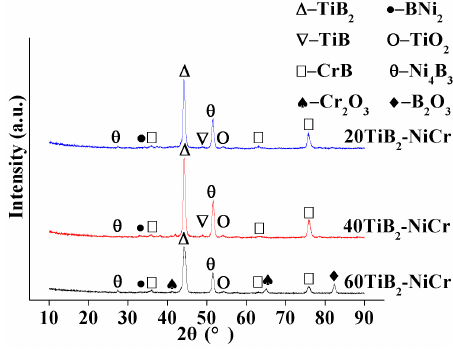
Figure 4. The XRD spectrum of three TiB 2 ‐ NiCr coatings.